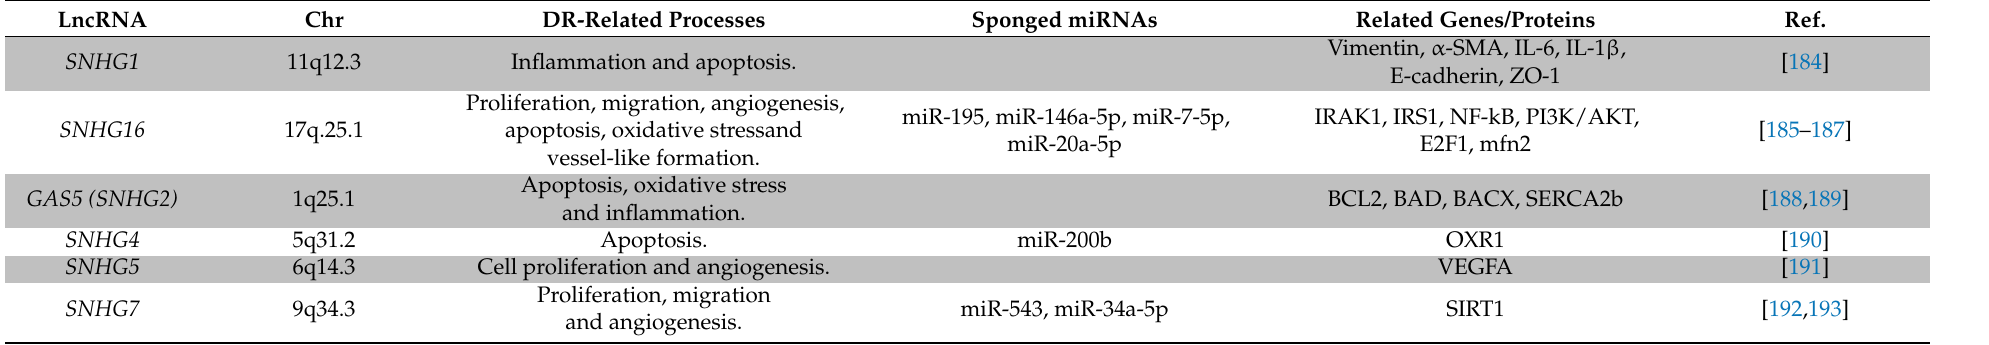
Table 3. Small nucleolar RNA host genes deregulated in diabetic